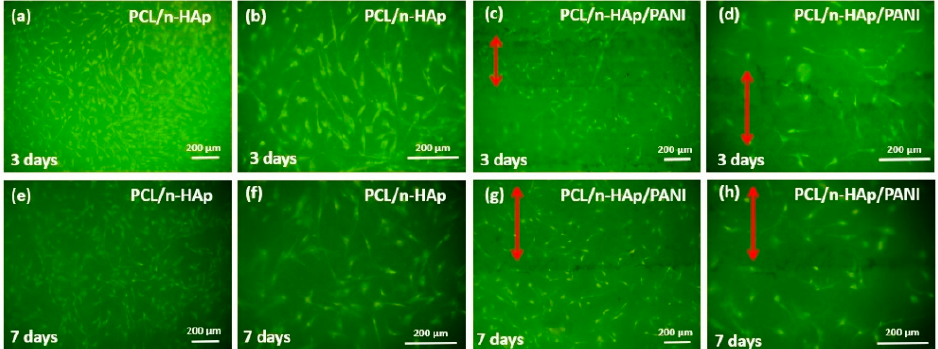
Figure 8. Morphology of NHOst cel culture for ( a – d ) 3 and ( e , f ) 7 days on the PCL/n-HAp electro- spun materials ( a , b , e , f ) and PCL/n-HAp/PANI materials ( c , d , g , h ). Scale bar is 200 μ m. Red arrows indicate areas with polyaniline applied.